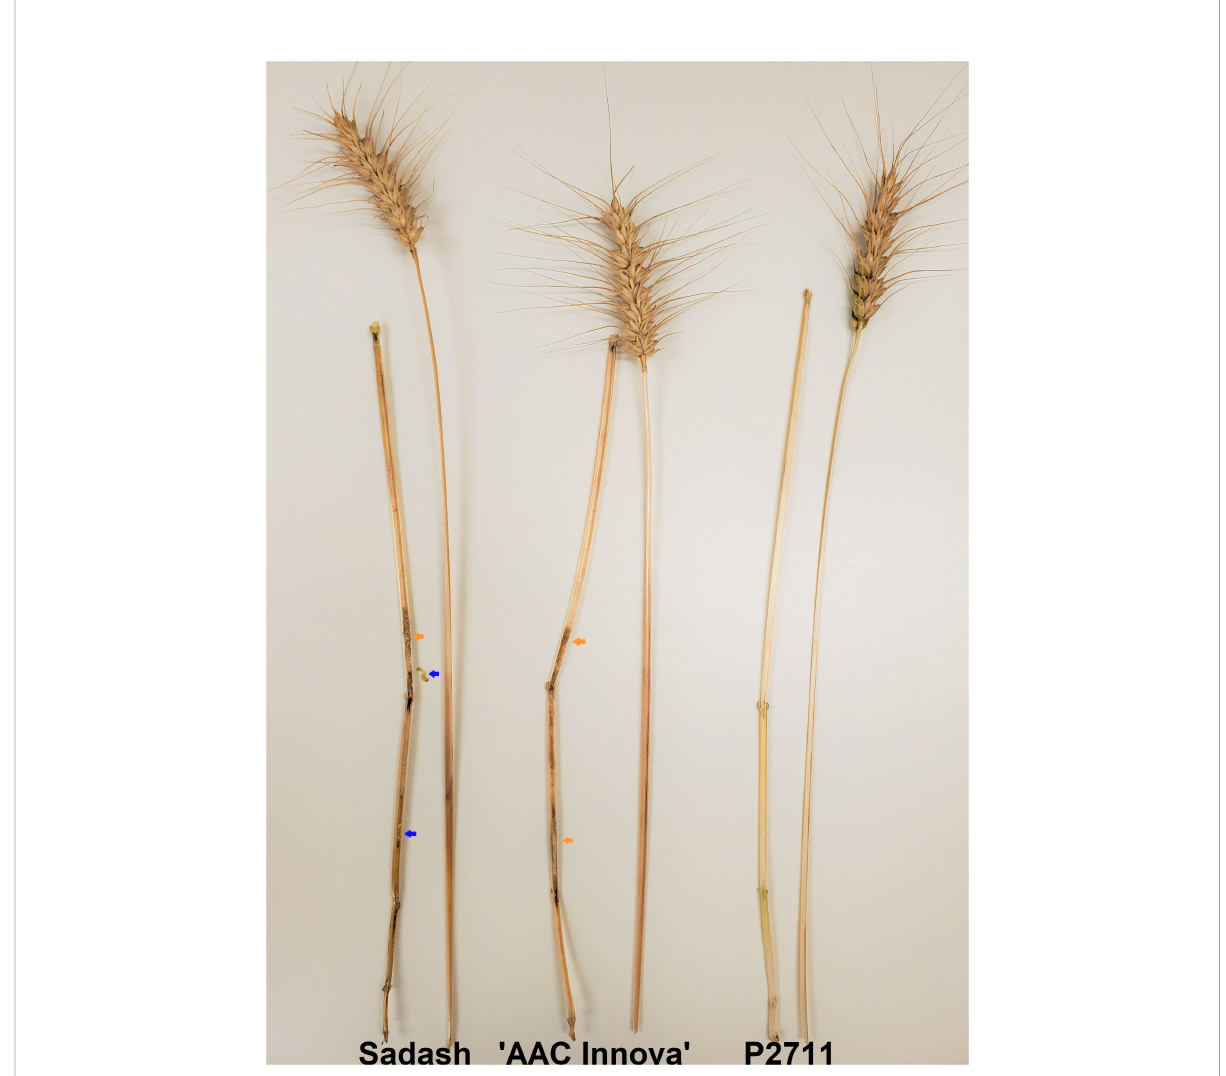
FIGURE 1 A representative picture of longitudinal dissection of stems (main tillers) of the three parental cultivars. Hollow stem cultivars Sadash and ‘ AAC Innova ’ are respectively shown on the left-hand side and in the middle while solid stem cultivar P2711 is on the right-hand side. Wheat stem saw fl y (WSS) larvae detected in the stem of Sadash are shown by blue arrows while the girdled section fi lled with larva frass in both hollow stem cultivars Sadash and ‘ AAC Innova ’ are shown by orange arrows. All internodes of the stem of P2711 are completely fi lled with pith and have no sign of WSS damage. The picture was taken from mature plant stems collected from an irrigated fi eld in Lethbridge, AB on September 1,